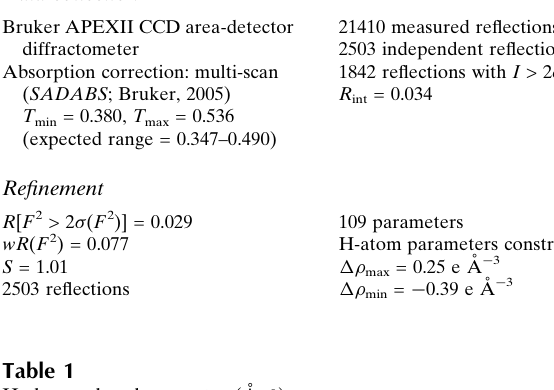
Hydrogen-bond geometry (A˚ , (cid:3)